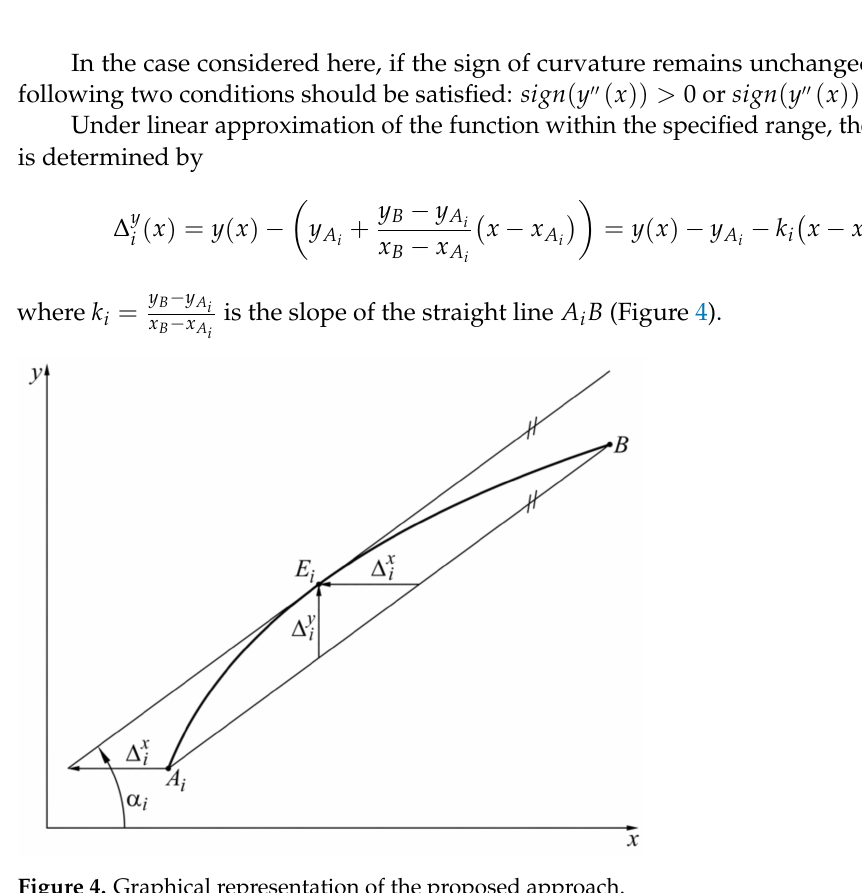
Figure 4. Graphical representation of the proposed